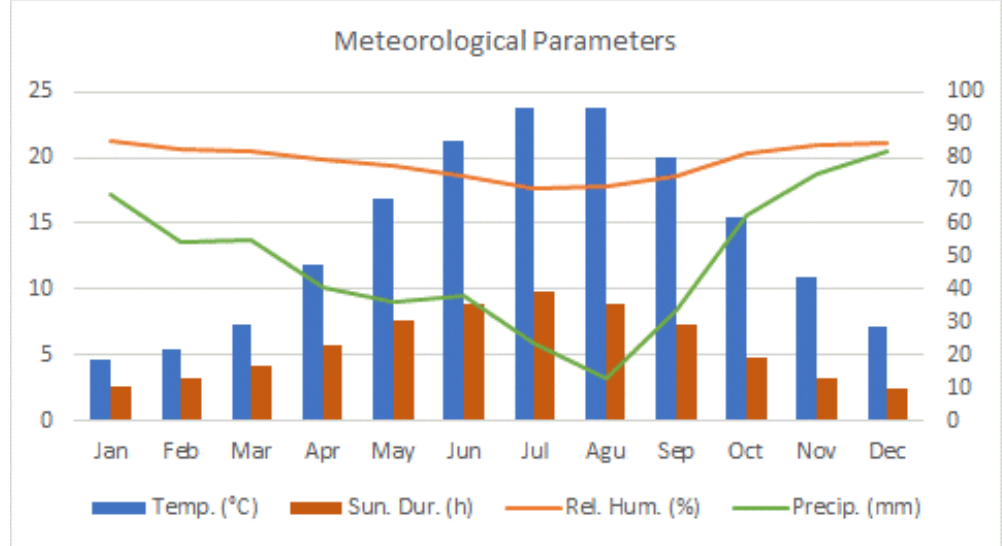
Figure 2. Selected meteorological parameters (1939 to 2018). Table 1. Statistical features of meteorological parameters.